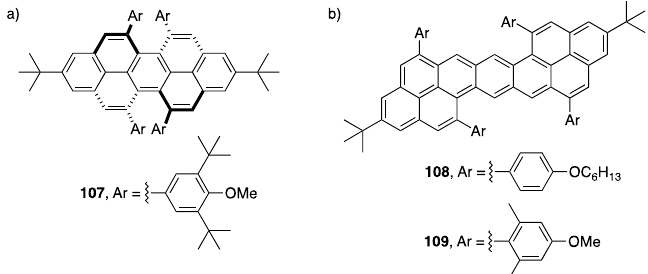
Figure 2. ( a ) Sterically hindered chiral peropyrene 107 [116]. ( b ) BDPs 108 and 109 synthesized by a four-fold alkyne benzannulation [117] .